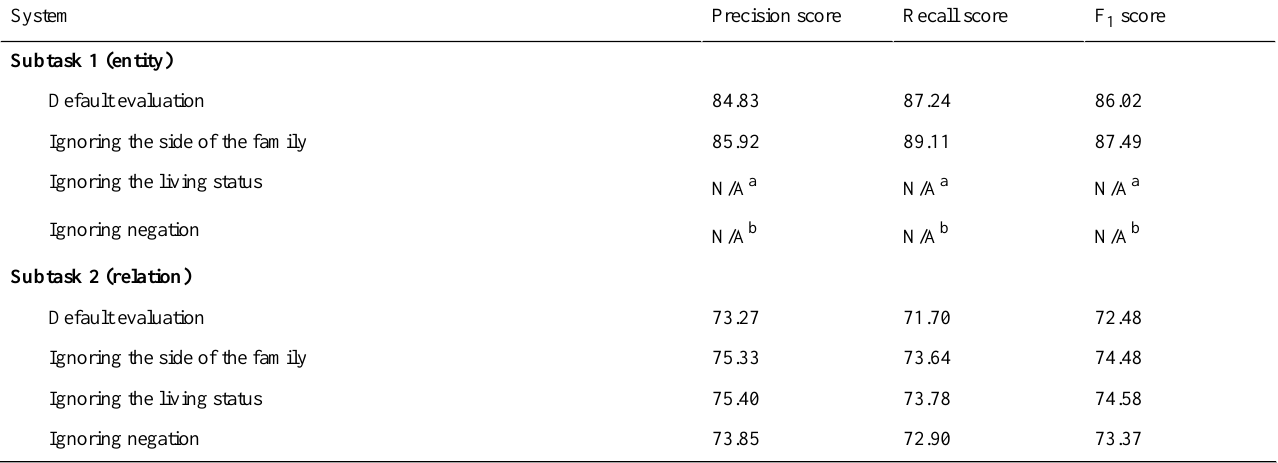
Table 7. Performance impact of attribute